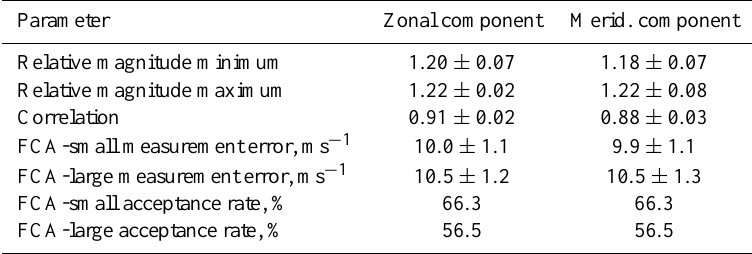
Table 3. Mean and standard deviation of daily relative magnitude minima and maxima, correlation, maximum measurement errors, and